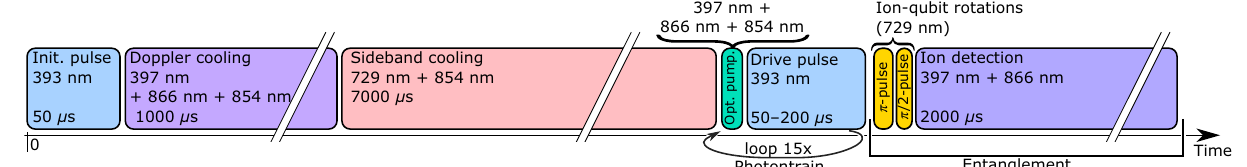
FIG. 9. Laser-pulse sequences for the experiments presented in the paper. An initialization laser pulse for intensity stabilization of the drive laser is followed by Doppler cooling. Subsequently, the ion is cooled close to the ground state of each of its three motional modes and prepared in the initial state | u (cid:2) = | S J = 1 / 2 , m j = − 1 / 2 (cid:2) via optical pumping (10 μ s of σ − -polarized 397-nm light combined with 866 nm; 854 nm for repumping from the D J = 5 / 2 manifold). For the multiphoton experiment (Sec. V) the drive-laser